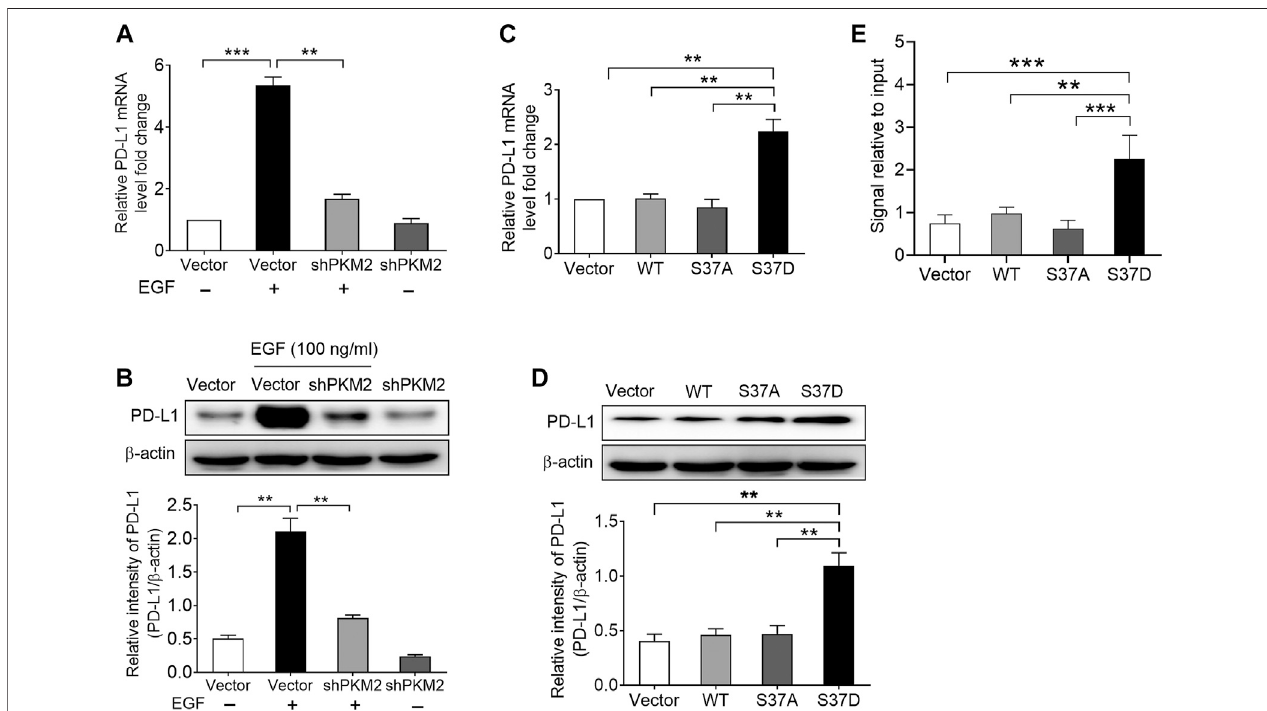
FIGURE 4 | Phosphorylation of PKM2 at Ser37 participates in EGF-induced PD-L1 expression. (A,B) PKM2 shRNA blocked EGF-induced PD-L1 mRNA (A) and protein (B) expressions in SNU-368 cells. At 24 h post-transfection, the cells were incubated in the presence or absence of 100 ng/ml EGF for 12 h. **p < 0.01, ***p < 0.001, one-way ANOVA, n (cid:2) 4 independent experiments per group. (C,D) The expression of a phosphorylation-mimic PKM2 S37D mutant induced a higher expression of PD-L1 mRNA (C) and protein (D) compared with WT PKM2 or the S37Amutantin SNU-368 cells. **p < 0.01, one-way ANOVA, n (cid:2) 4 independent experiments per group. (E) ChIP analyses showed that the expression of a phosphorylation-mimic PKM2 S37D mutant resulted in increased binding of PKM2 to PD-L1 promoter in SNU-368 cells. *p < 0.05, **p < 0.01, one-way ANOVA, n (cid:2) 5 independent experiments per group.